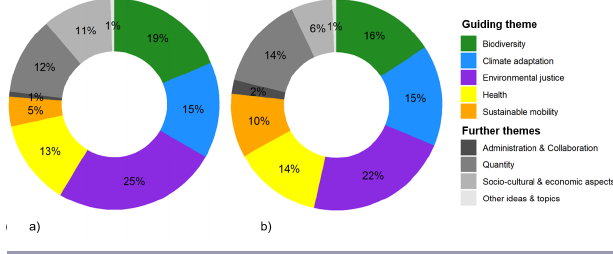
Fig. 2 . Allocation of a) ideas (n = 3808) and b) topics (n = 2917) for the improvement and development of GBI, raised by survey respondents, to guiding themes of the planning